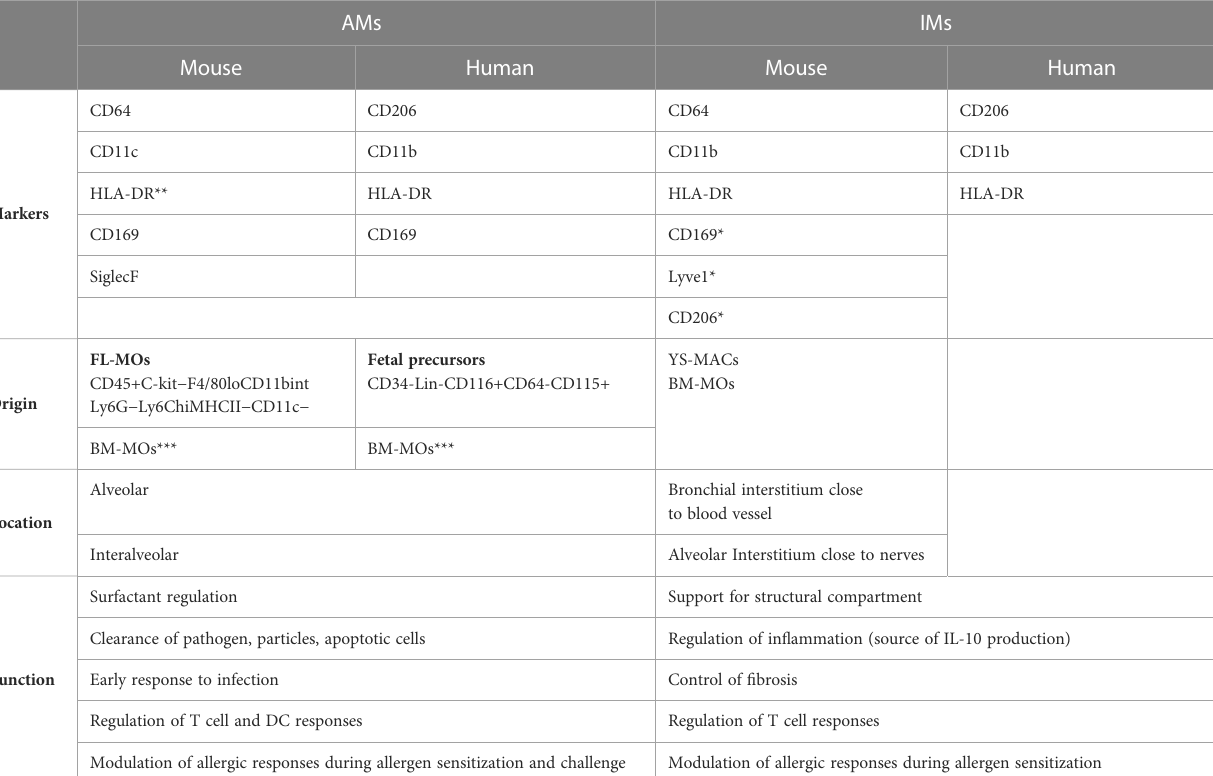
TABLE 1 Identi fi cation of alveolar macrophages and interstitial macrophages in mouse and human according to speci fi c surface markers expression, origin, location and function.